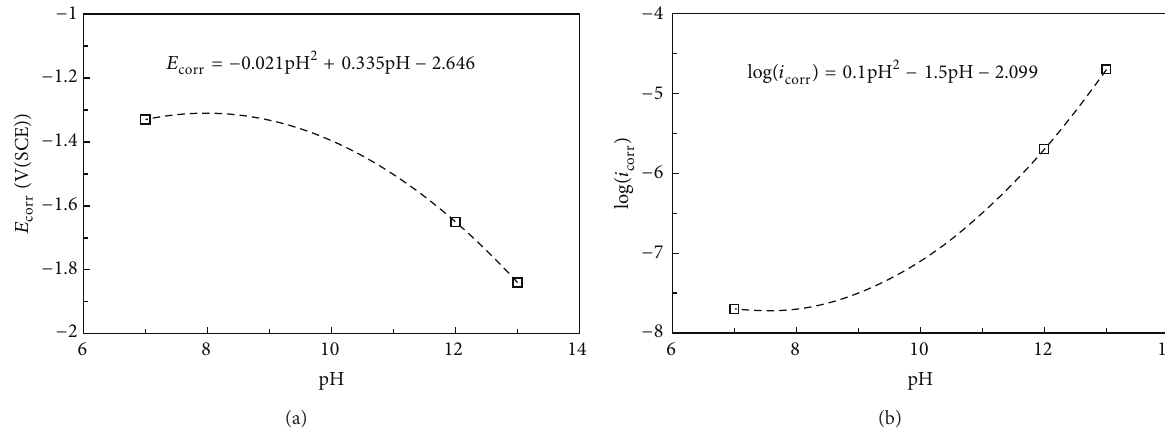
Figure 1: (a) Corrosion potential and (b) corrosion current density as functions of pH. The experimental data was obtained using the plots reported by Lee and Pyun [12]. Superimposed on the plots are quadratic lines that represent a fit to the data.